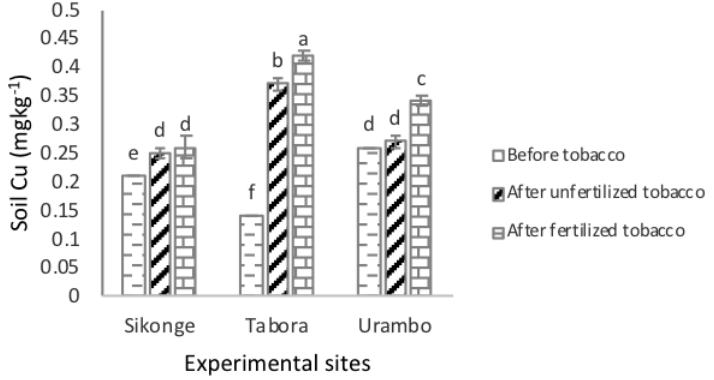
Figure 2. Effect of tobacco and NPK + CAN fertilization on the extractable Cu in soils.